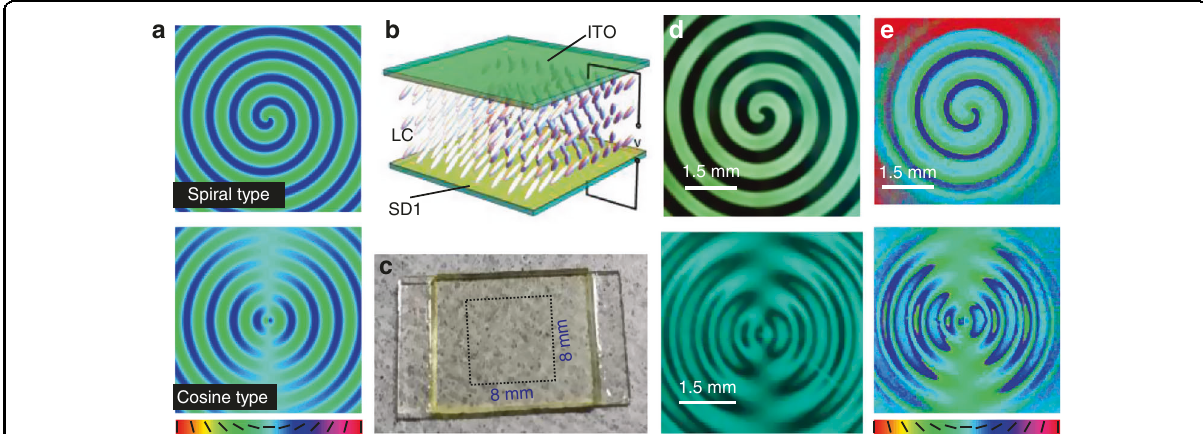
Fig. 2 Fabrication of the PBOEs for oscillated PSHE. a Predesigned axis distributions of PBOEs. b Schematic of liquid crystal (LC) cell. c , d Photograph and polarizing micrographs of the fabricated LC elements . e Measurement results of the axis distributions